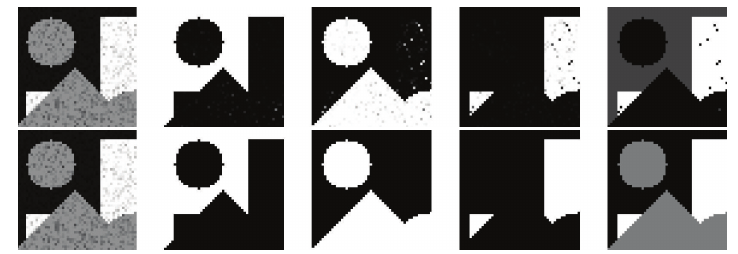
Figure1:Experiment1:robustnesstonoise.Thefirstline:segmentationusingShen’smodel.Thesecondline:segmentationusingtheproposed model. For each line, from left to right are original image, three membership functions, and hard segmentation after